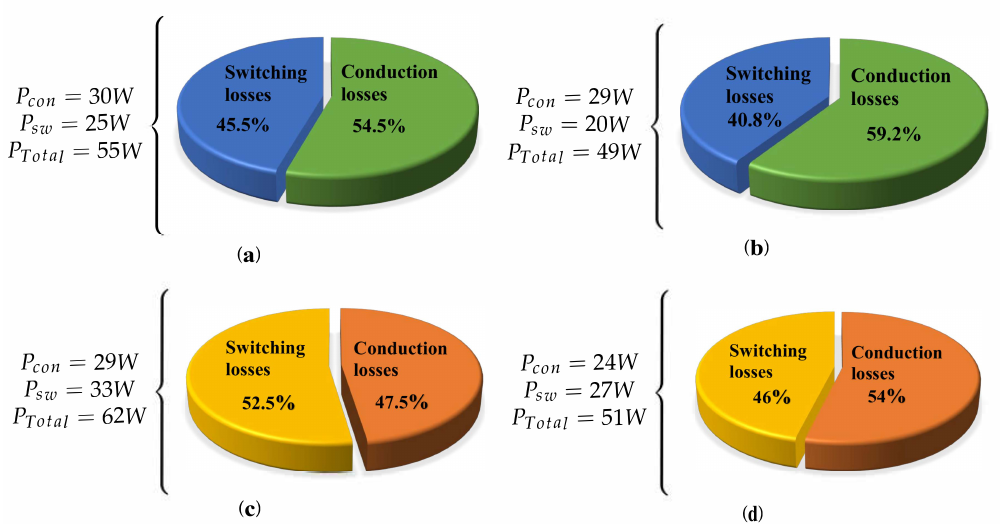
Figure 11. Different configuration MPC schemes for efficiency assessment at 4 kW rated power. ( a ) Distribution Please change labels k–n to a–d for conduction and switching losses of 2L-VSC using the conventional (CMPC) scheme, ( b ) distribution for conduction and switching losses of 2L-VSC using the improved (IMPC) scheme, ( c ) distribution for conduction and switching losses of 2L-VSC using the M 2 PC scheme, and ( d ) distribution for conduction and switching losses of 2L-VSC using the periodic (PMPC)